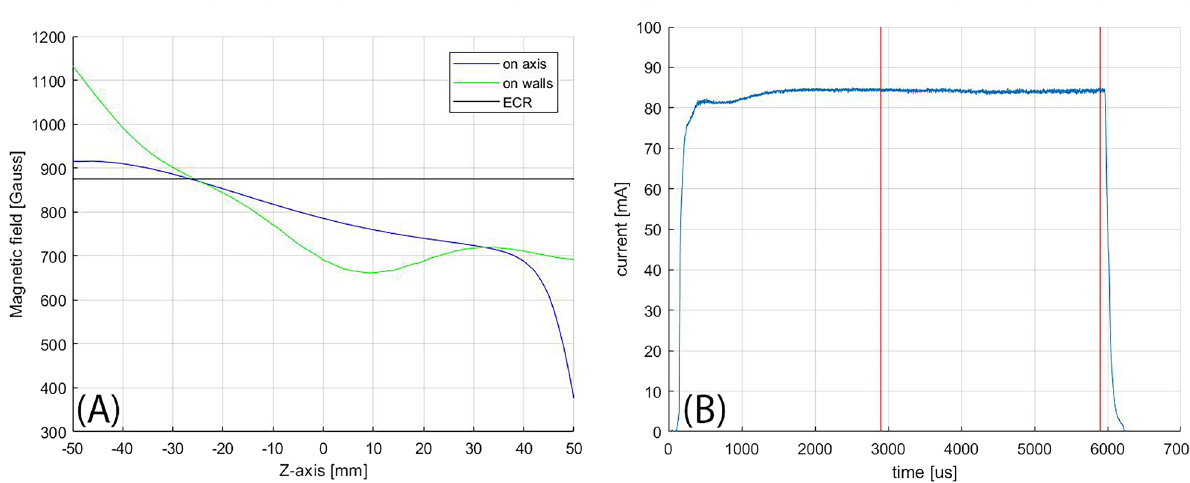
Figure 10. ( A ) Magnetic field configuration of HSMDIS configuration; ( B ) Corresponding beam pulse shape produced: only the beam produced within the red lines is transmitted to the